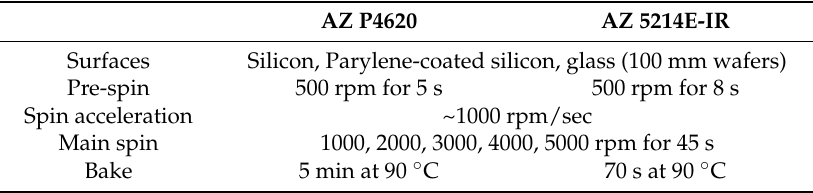
Table 3. Parameters for photoresist spin curves on different surfaces.